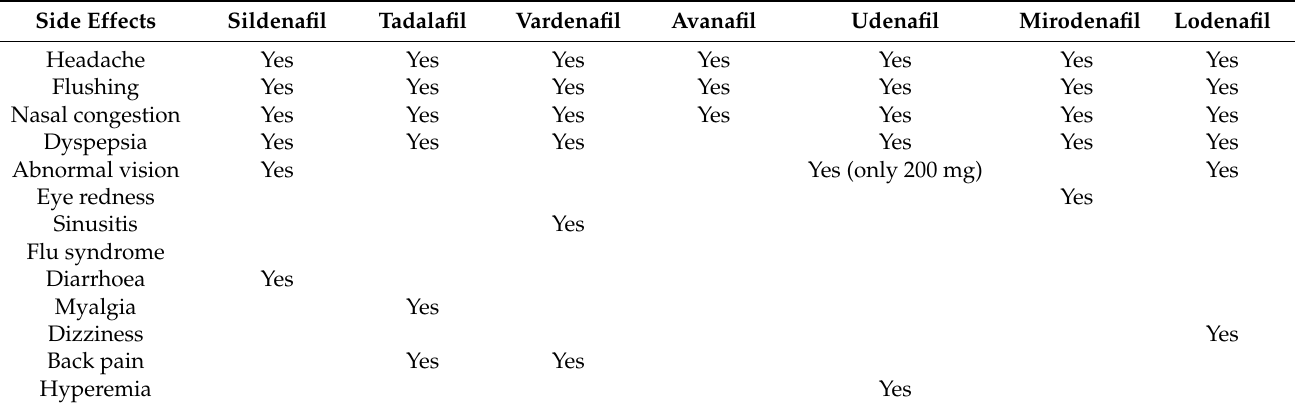
Table 1. Common side effects of Phosphodiesterase type 5 (PDE5)